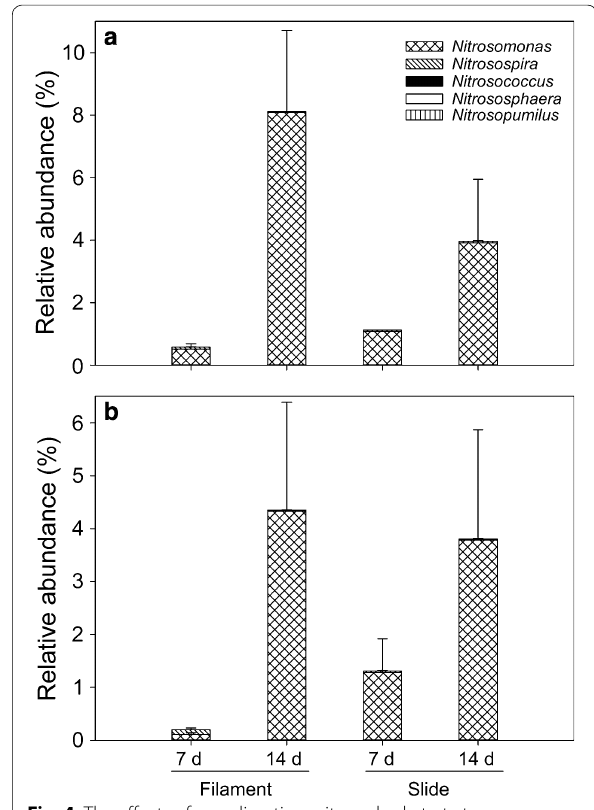
Fig. 4 The effects of sampling time, site and substrate type on ammonia-oxidizing microorganisms in the community attached to artificial substrates. a Site A lentic; b Site B = =